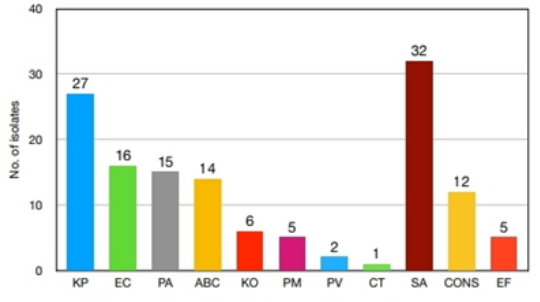
Fig. 2. Bacteriological profile of diabetic foot infection (n=135). *Abbreviations for the name of bacterial species: KP-Klebsiella pneumoniae, EC-Escherichia coil, PA-Pseudomonas aeruginosa, ABC-Acinetobacter baumannii complex, KO-Klebsiella oxytoca, PM-Proteus mirabilis, PV- Proteus vulgaris, CT-Citrobacter species, SA-Staphylococcus aureus, CONS-